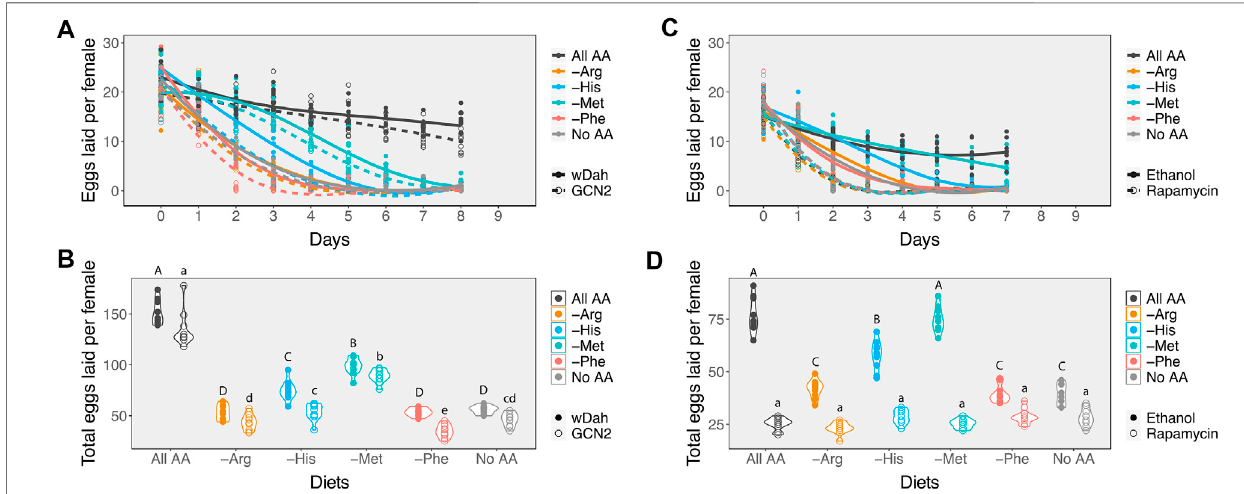
FIGURE 3 | Inhibiting either the GCN2 or Target of Rapamycin pathways alters the impact of diet on egg laying. (A) Changes in the rate of decline in egg laying in response to amino acid availability in the diet between control (wDah, solid circles and lines) and GCN2 Δ fl ies (open circles and dashed lines). (B) Mean number of eggs